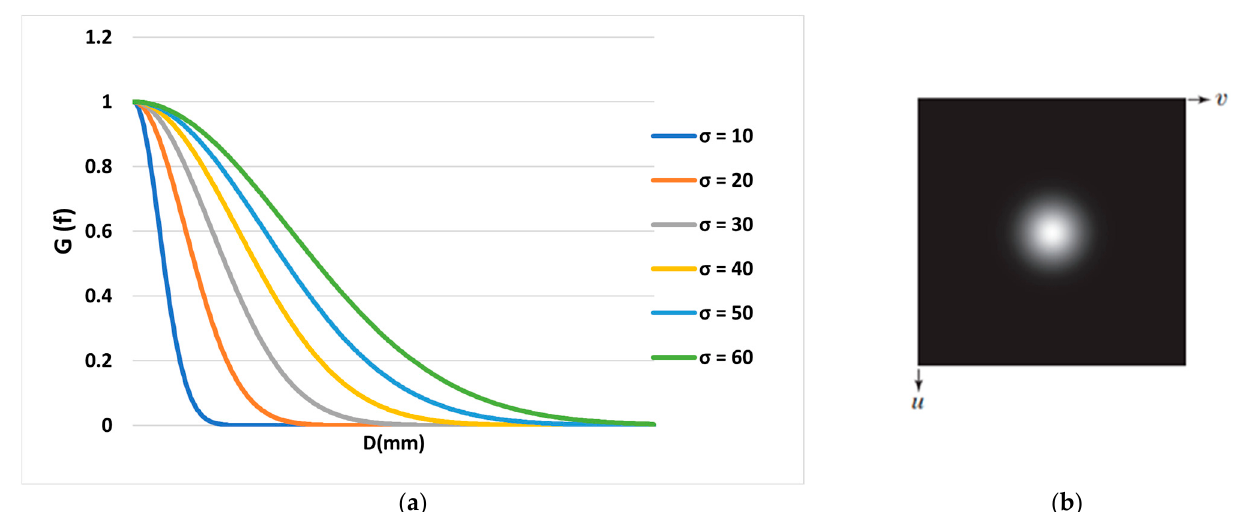
Figure 3. ( a ) Gaussian filter diagram according to the distance from the point to the center of the filter and ( b ) Gaussian filter function display as an image.